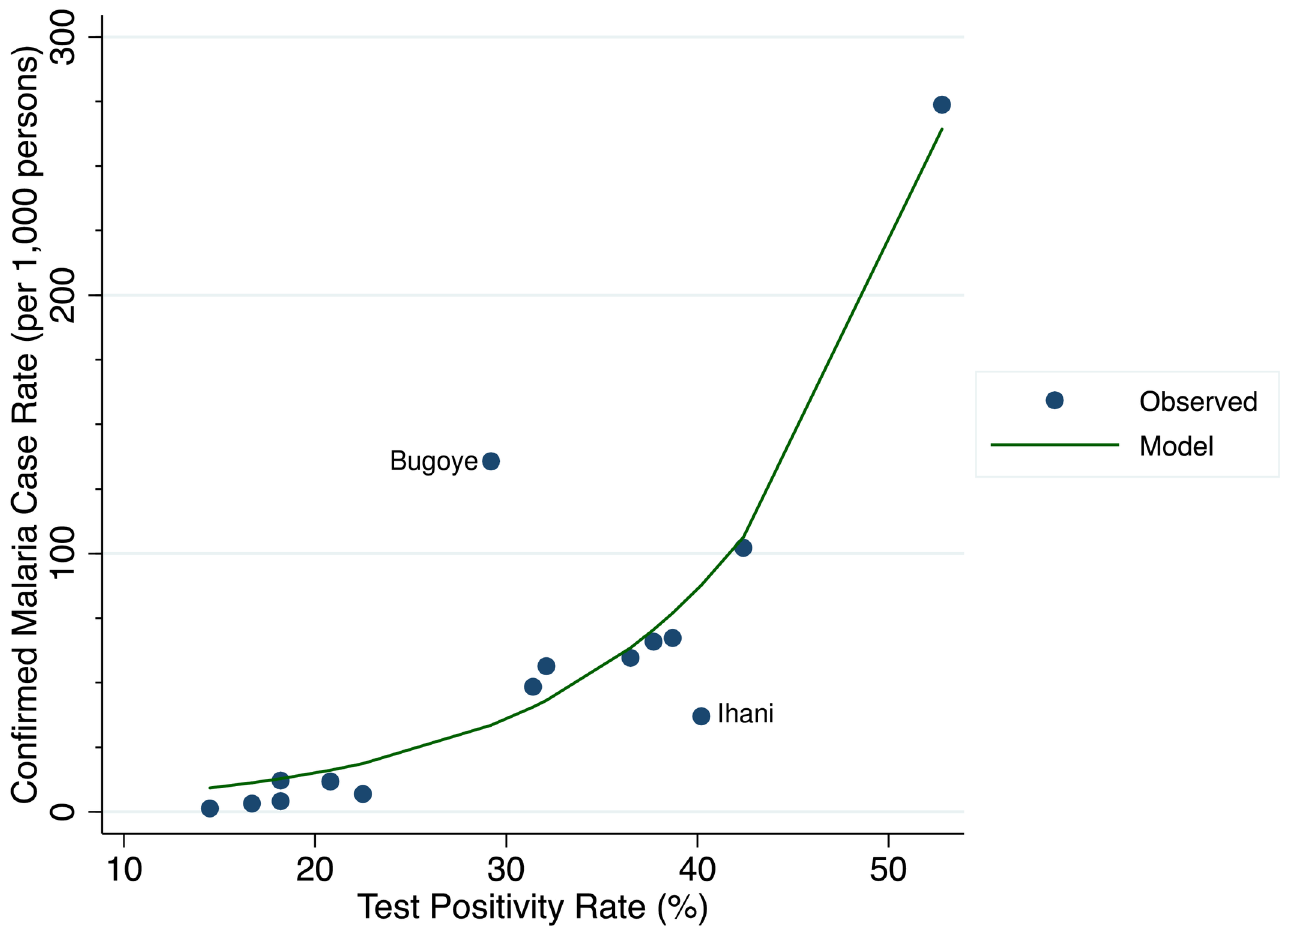
Fig 2. The relationship between the confirmed malaria case rate and test positivity rate for individual villages over the 24-month study period.